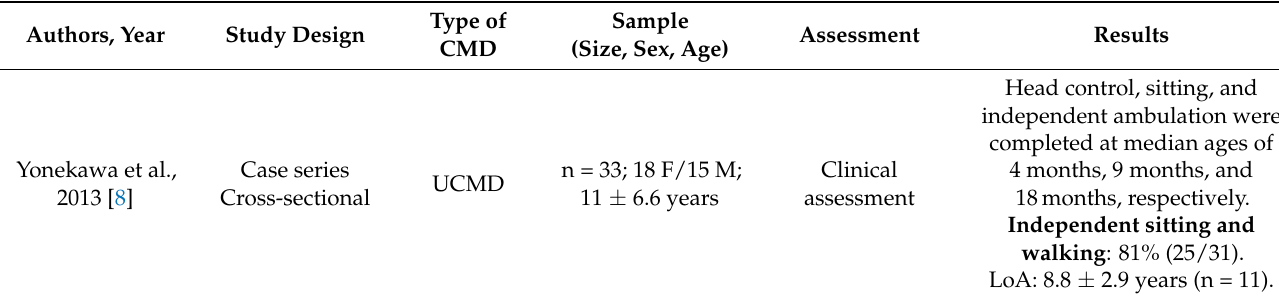
Table 1. Motor outcome measures in patients with COL6-RD (UCMD: Ullrich congenital